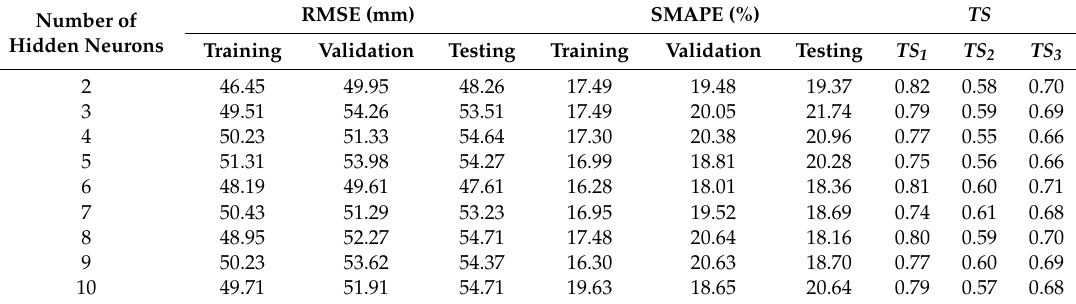
Table 5. The performance for training, validation, and testing parts of the LSTM model with selected nine input variables. Number of Hidden Neurons